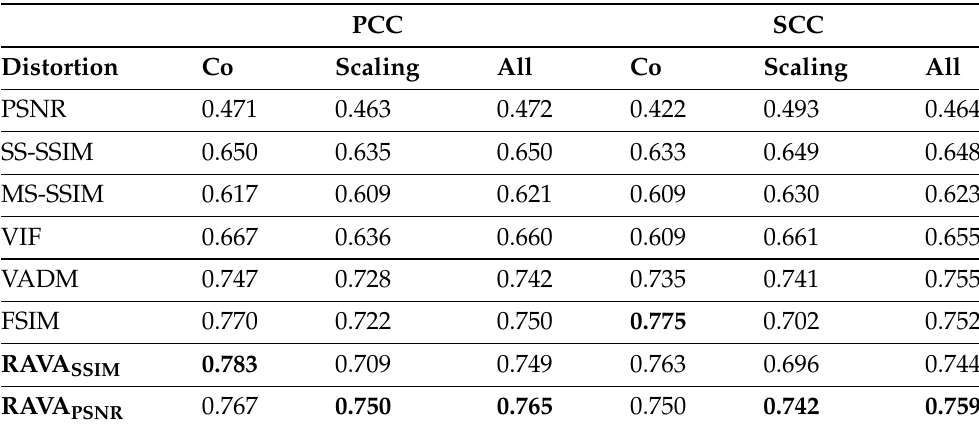
Table 6. Comparison of PCC and SCC on the MCL-V